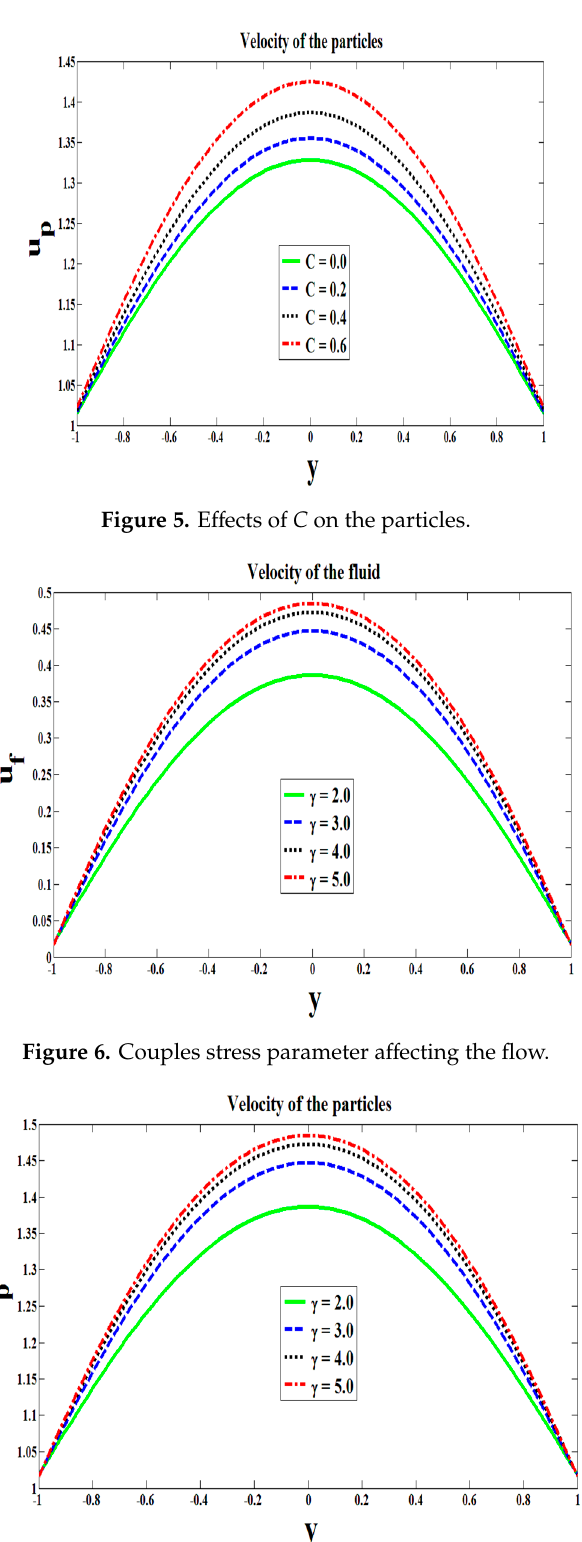
Figure 4. Effects of 𝐶 on the flow.